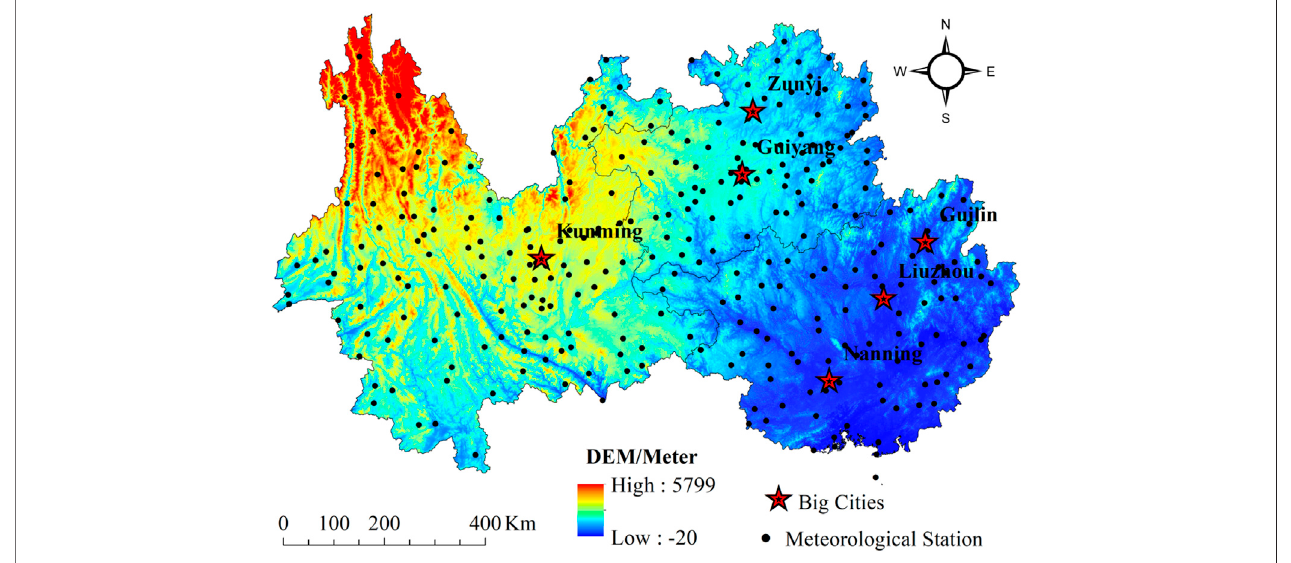
FIGURE 1 | Elevation of the study area and the spatial distribution of weather